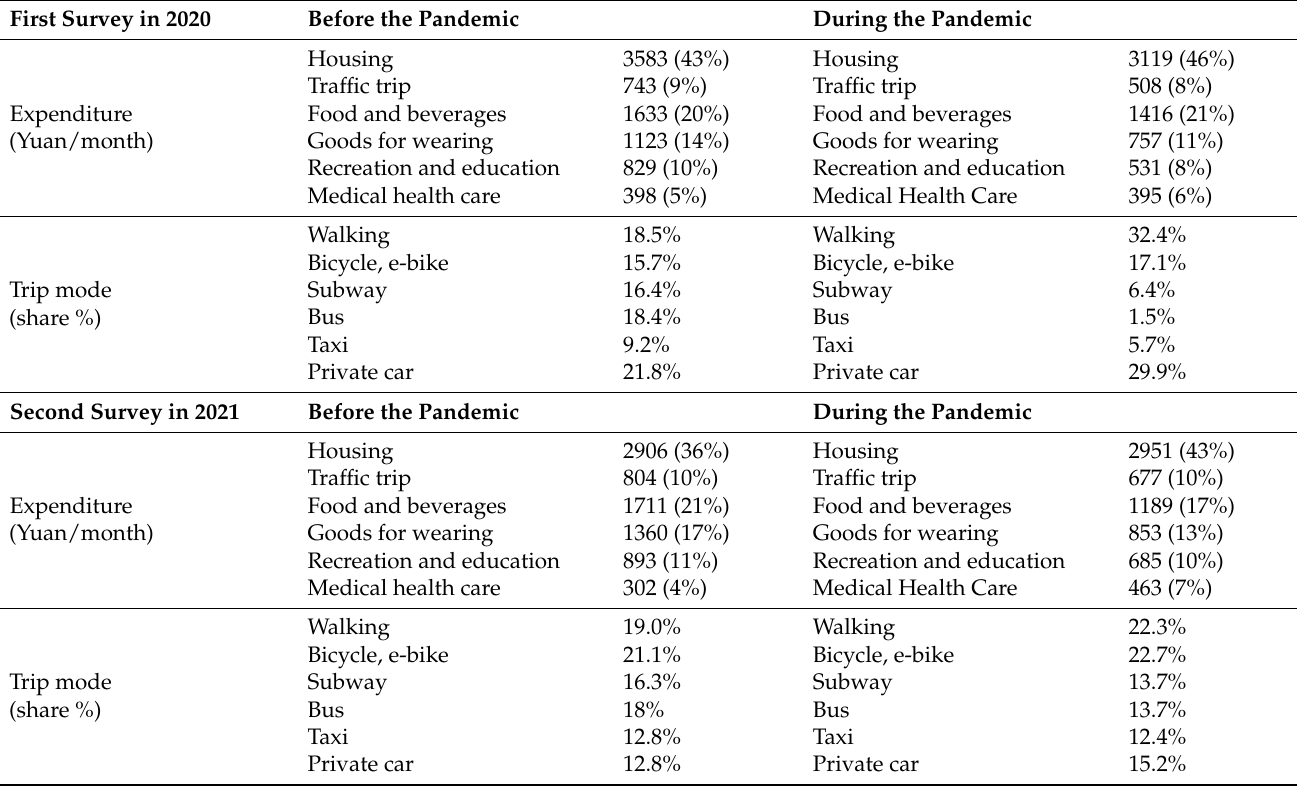
Table 2. Consumption expenditure and trip choice before and during the pandemic in two